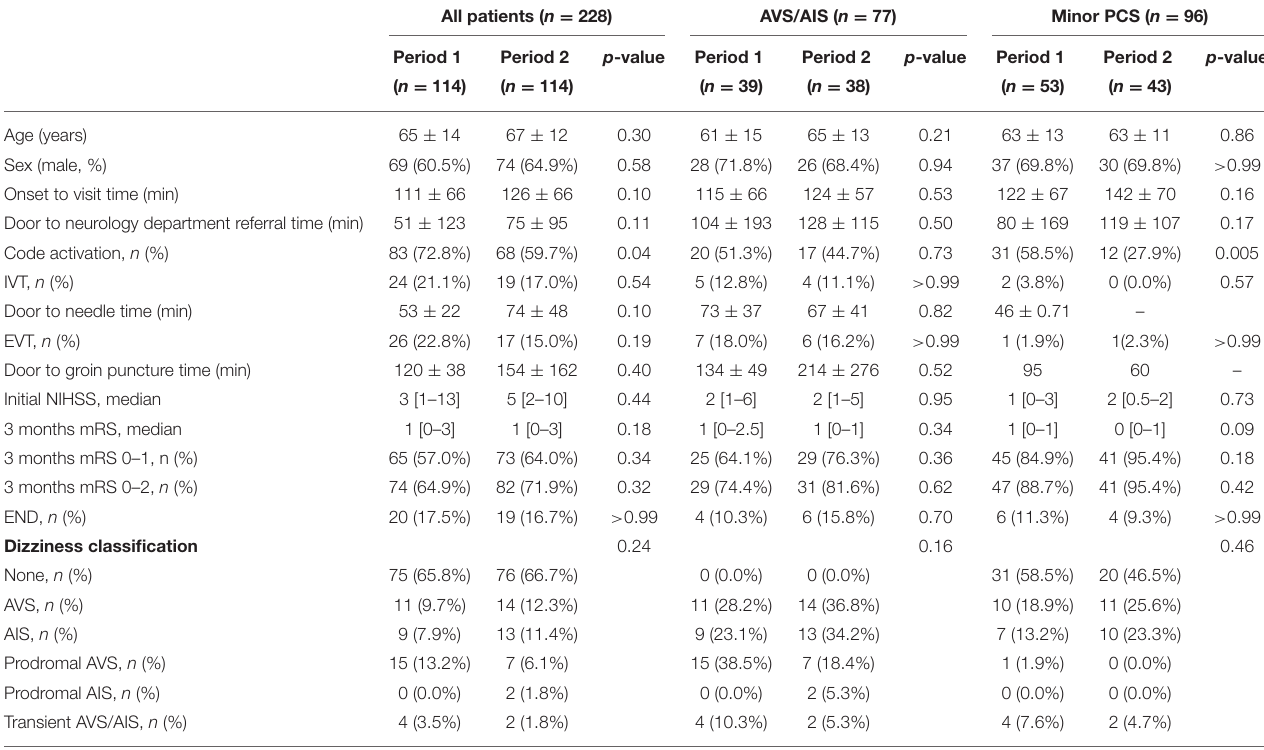
TABLE 2 | Demographics, hyperacute treatments, and dizziness classification of enrolled patients. All patients ( n =